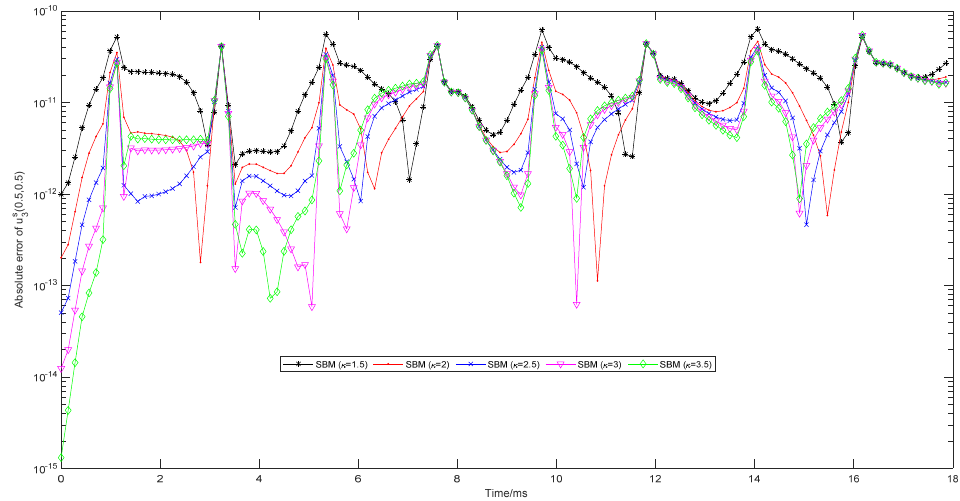
Figure 4. Time history of absolute error of u s 3